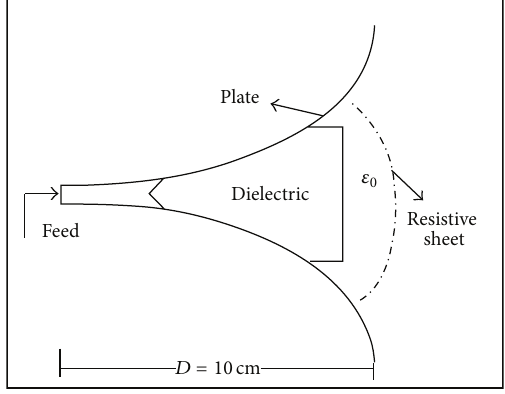
Figure 1: Vivaldi Shaped TEM horn antenna (PDVA10) [7].